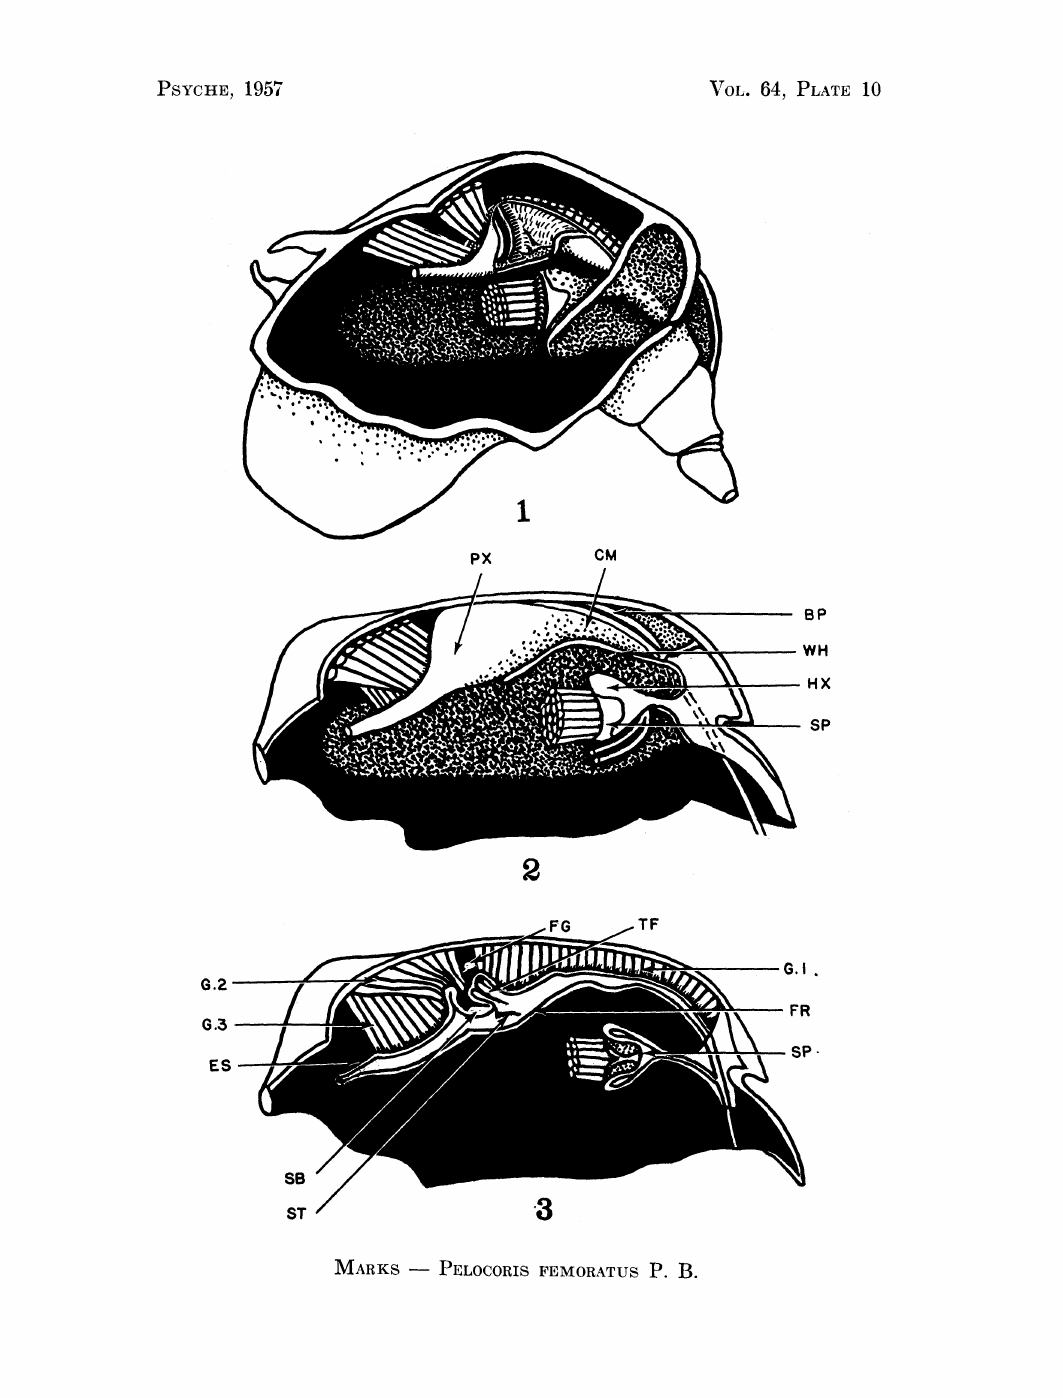
MARKS- PELOCORIS FEMORATUS P.